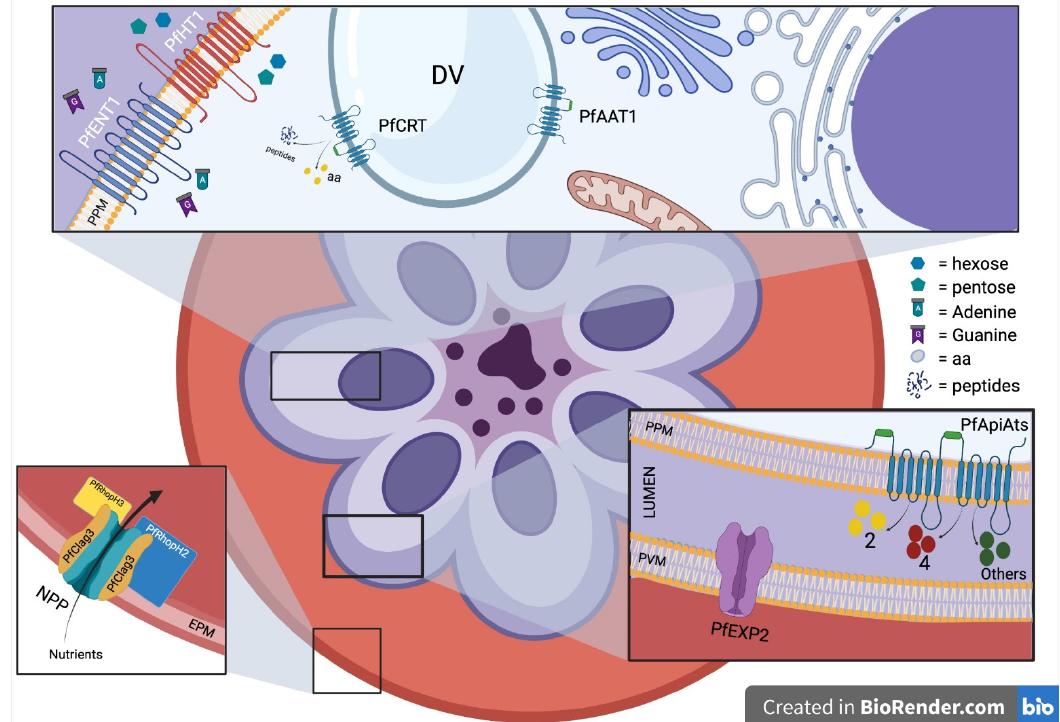
Figure 1. Schematic representation of transporters in a P. falciparum -infected erythrocyte. Nutrients in the extracellular milieu must be trafficked across multiple membranes to reach the parasite, including the host cell membrane, the PVM, and the PPM. Known transporters include the following: At the host cell membrane, the PfCLAG3 channel is induced by intracellular parasites through the NPP, facilitating uptake of extracellular nutrients (bottom left inset image). PfENT1 and PfHT1 at the PPM are nucleoside and sugar transporters, respectively (upper inset image). PfApiATs function as amino acid transporters at the PPM (bottom right inset image). PfEXP2 is a pore-forming component of the Plasmodium translocon of exported proteins (PTEX) and exports parasite proteins into the erythrocyte cytosol (bottom right inset image). PfAAT1 is an amino acid transporter localized to the DV, while PfCRT exports small molecules from the DV lumen to the parasite cytosol (upper inset image). Aa—amino acid; DV—digestive vacuole; EPM—erythrocyte plasma membrane; NPP—new permeability pathways; PPM—parasite plasma membrane; and PVM—parasitophorous vacuole membrane.